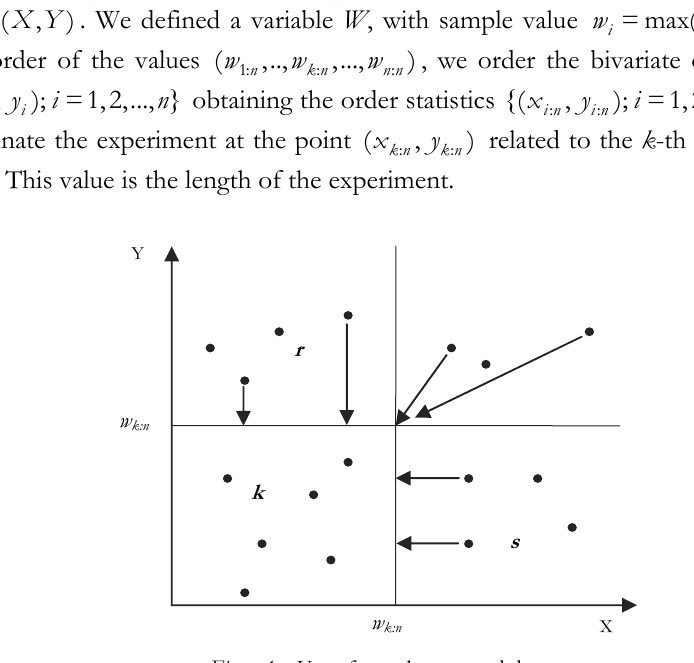
Figure 1 – Use of sample censored